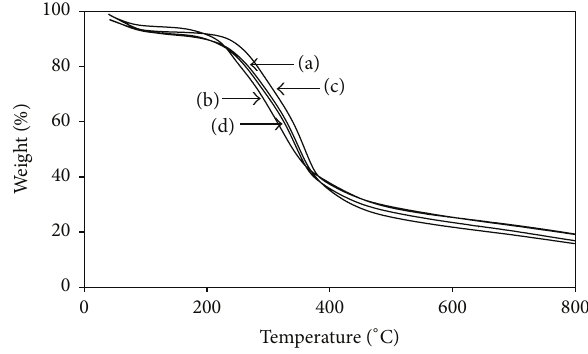
Figure 6: Thermogravimetric degradation curves of raw material (a), degreased material (b), microwave-assisted water treatment material (c), and IMSHE treatment